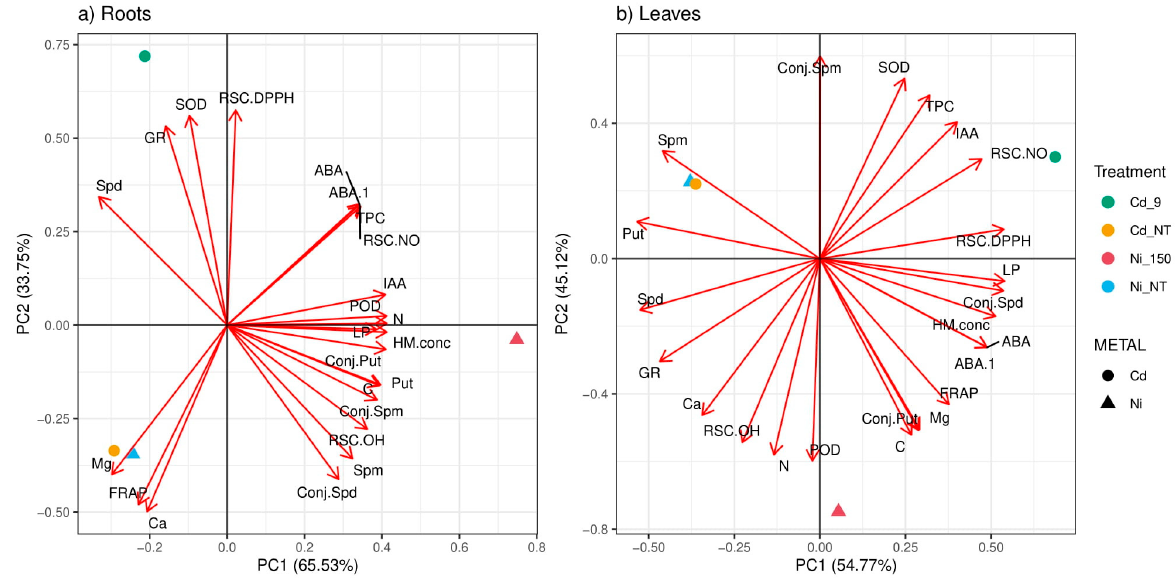
Figure 5. Principal Component Analyses (PCA) with treatment and heavy metal treatment as a dependent variable separately using root (a) and leaf (b) samples. Treatments include: Cd 9 ( P. dependent variable separately using root ( a ) and leaf ( b ) samples. Treatments include: Cd 9 ( P. deltoides deltoides grown in soil supplemented with 9 ppm Cd); Cd_NT (poplar cuttings grown in grown in soil supplemented with 9 ppm Cd); Cd_NT (poplar cuttings grown in non-treated soil); Ni non-treated soil); Ni 150 (poplar cuttings grown in soil supplemented with 150 ppm of Ni); and 150 (poplar cuttings grown in soil supplemented with 150 ppm of Ni); and Cd_NT (poplar cuttings Cd_NT (poplar cuttings grown in Cd non-treated soil). The following abbreviations examined pa- grown in Cd non-treated soil). The following abbreviations examined parameters. TPC: total phenolic rameters. TPC: total phenolic content; FRAP: ferric reducing antioxidant power; LP: lipid peroxi- content; FRAP: ferric reducing antioxidant power; LP: lipid peroxidation; SPD: spermidine;